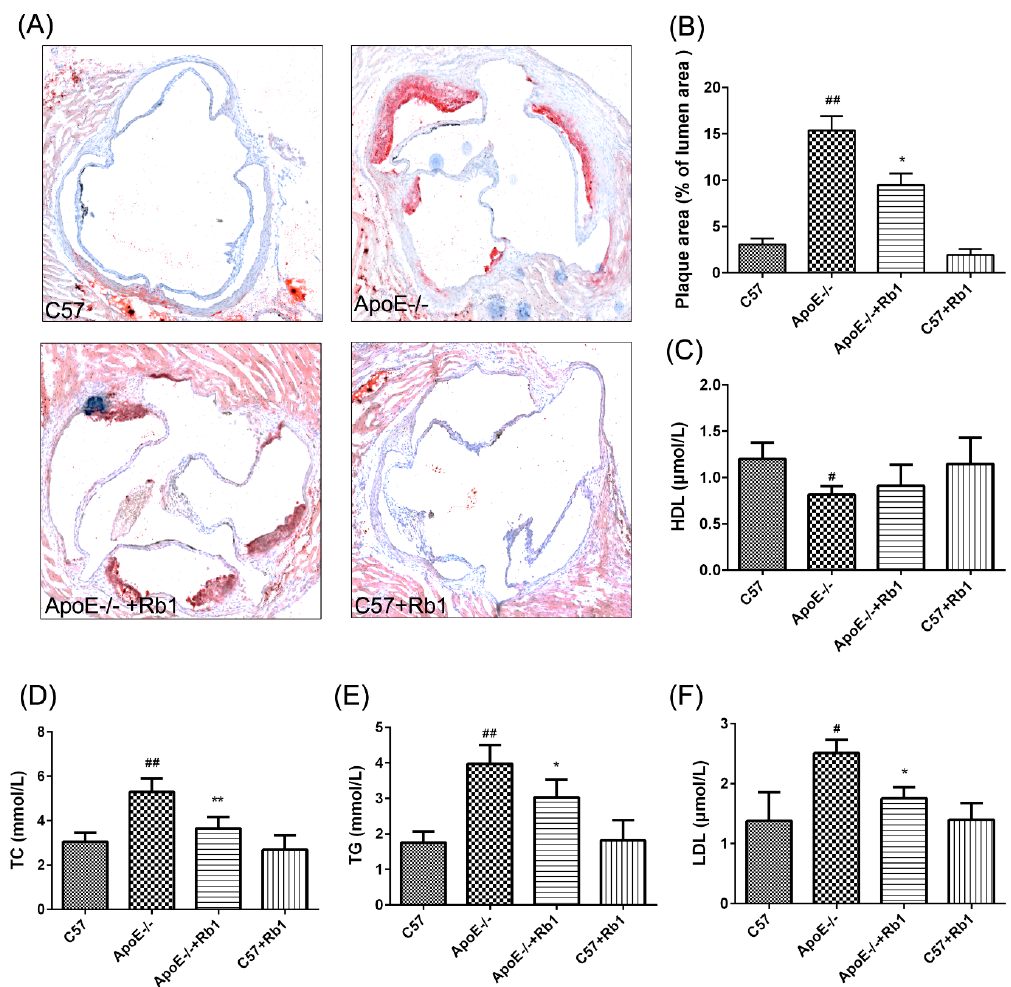
Figure 3. Rb1 reduced atherosclerotic development in ApoE-/- mice. ( A ) Atherosclerotic plaque formation assessed using Oil Red O staining. ( B ) Quantification of plaque areas using ImageJ software. ( C ) HDL-C levels, ( D ) TC levels, ( E ) TG levels, and ( F ) LDL-C levels. Each bar represents the mean ± the standard error (SE) of the mean in each group ( n = 10). ## p < 0.01, # p < 0.05 vs. C57